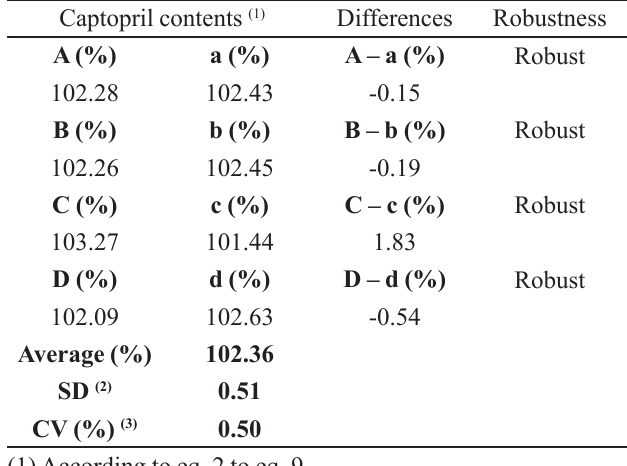
TABLE IX - Youden and Steiner parameters for method